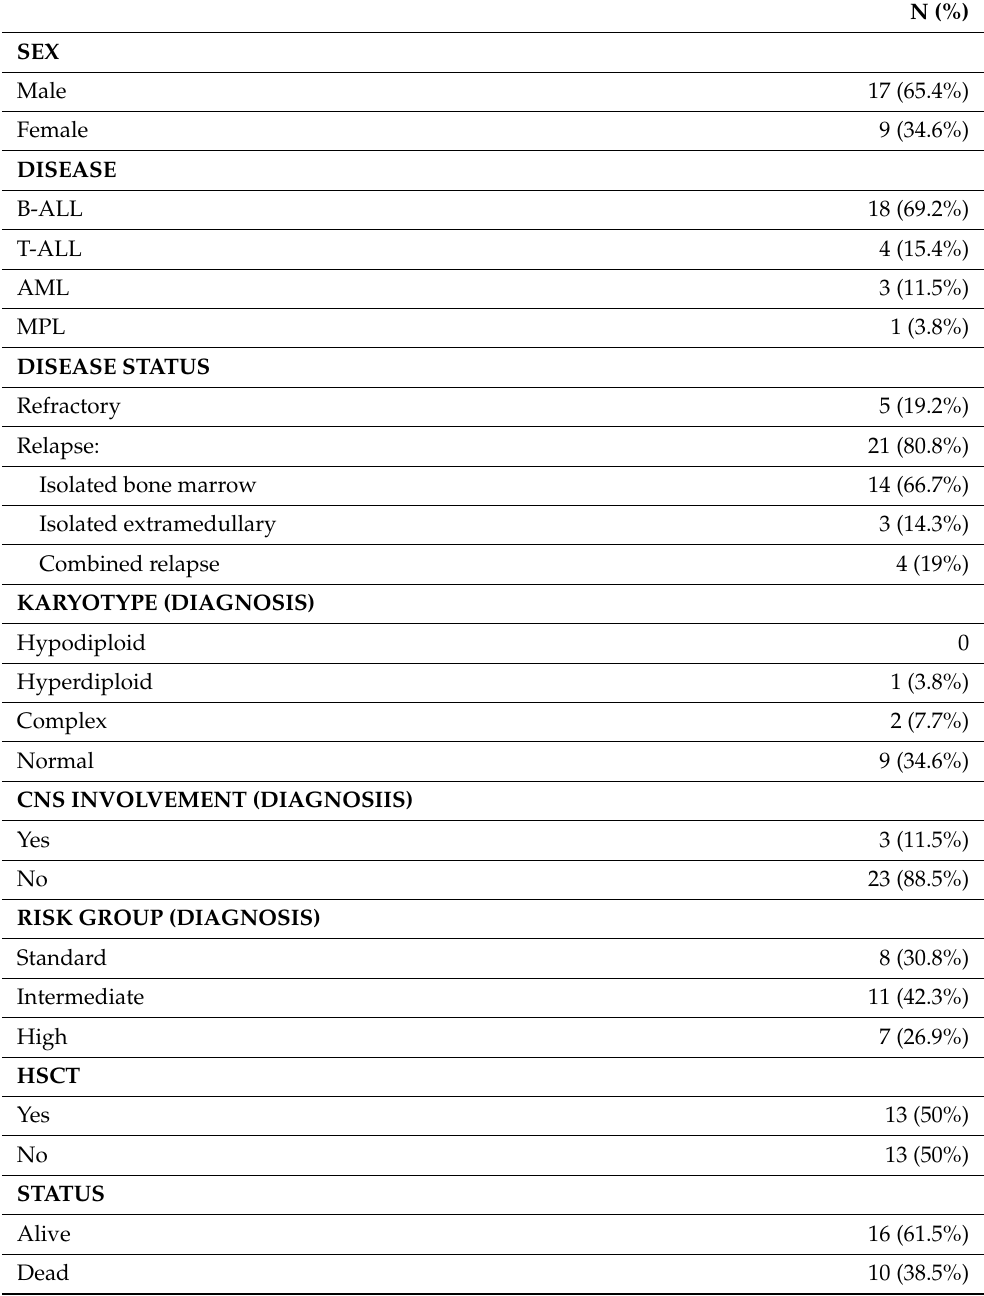
Table 1. Summary of clinical